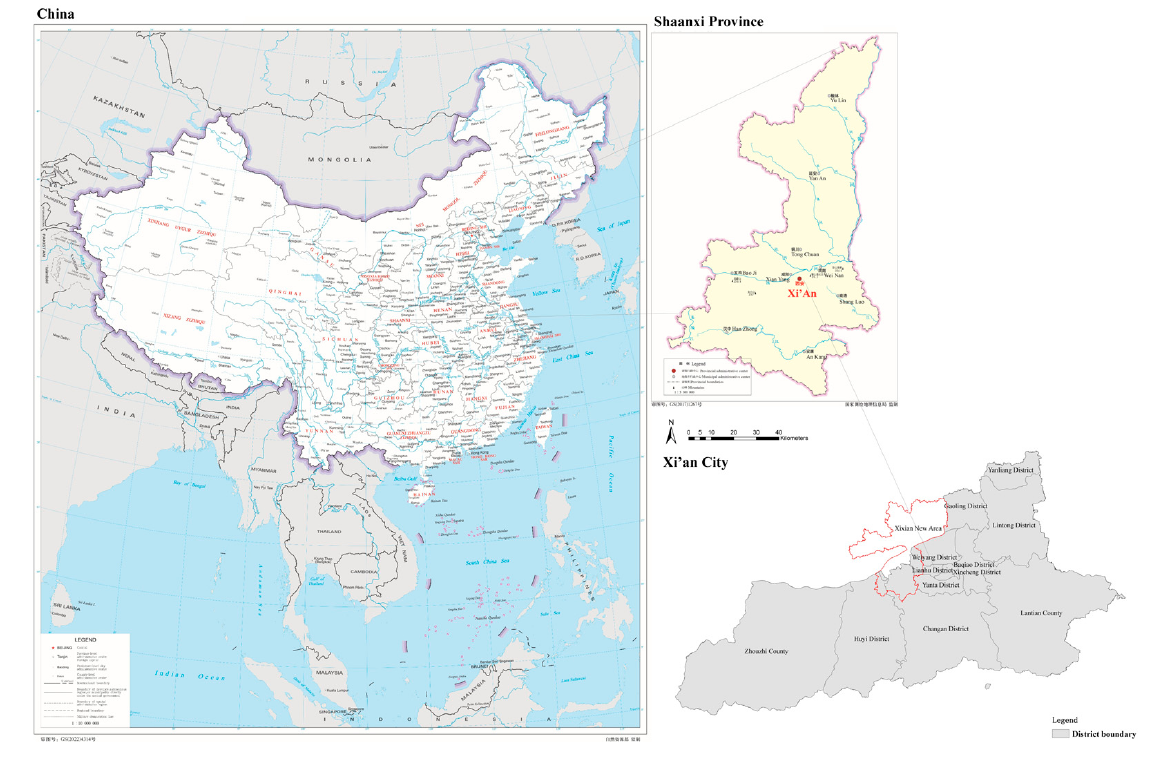
Figure 2. The location of Xi’an.